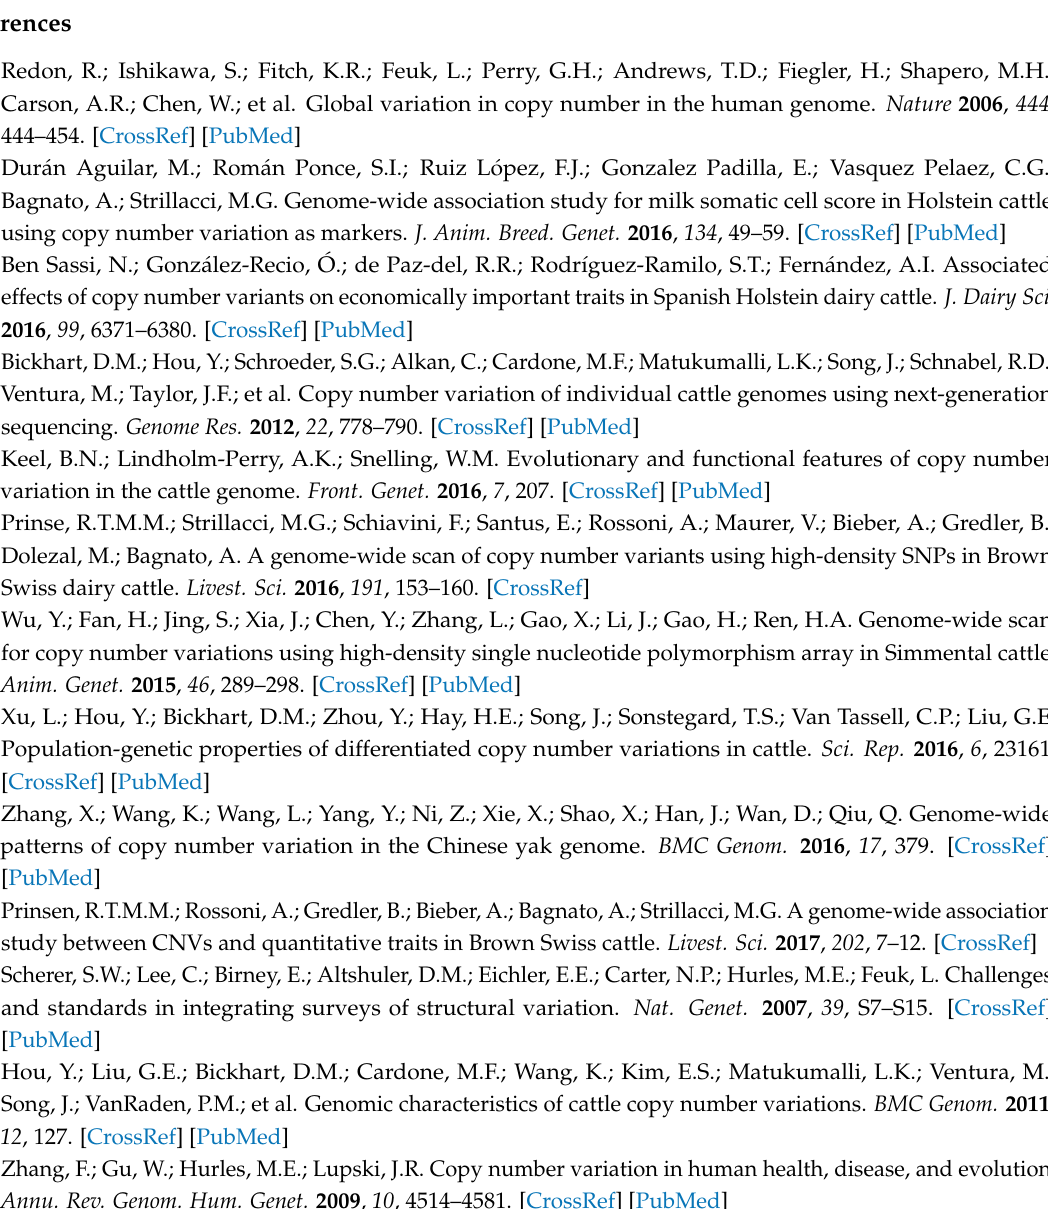
Table S1: Distribution of the KLF6 gene CNV types among yak breeds, Table S2: Pairwise comparison of CNV of the KLF6 gene in five Chinese domestic yak breeds, Online available: http://datadryad.org/review?doi=doi: